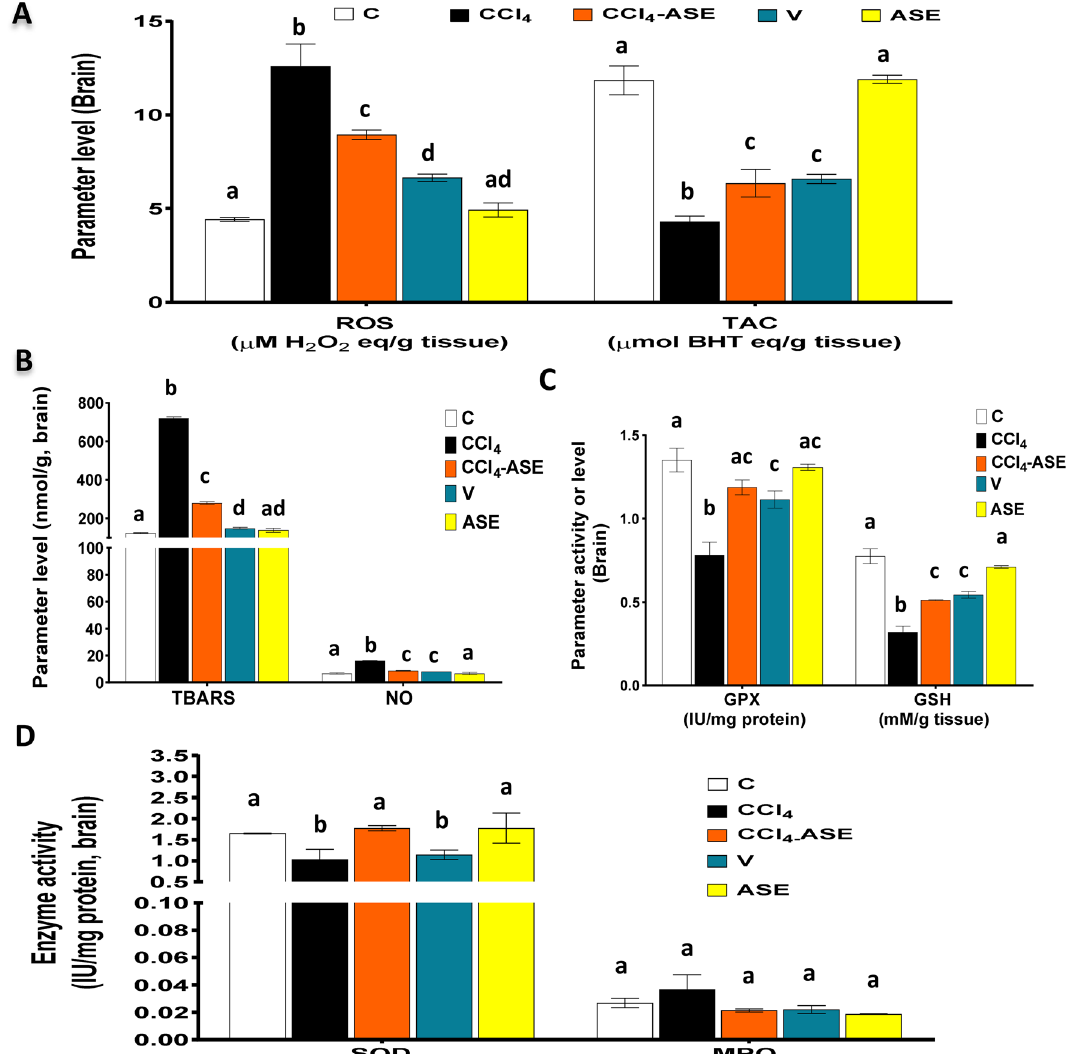
Figure 3. Ameliorating effect of ASE on the CCl 4 -induced redox state disturbance in the brain tissue. ( A ) reactive oxygen species (ROS) and total antioxidant capacity (TAC) levels. ( B ) thiobarbituric acid reactive substances (TBARS) and nitric oxide (NO) levels. ( C ) reduced glutathione (GSH) level and glutathione peroxidase (GPX) activity. ( D ) superoxide dismutase (SOD) and myeloperoxidase (MPO) activities. Results are expressed as mean ± S.E of 7 animals. BHT butylated hydroxytoluene, C control untreated rats, V olive oil (vehicle of CCl 4 )-administered rats (0.5 ml/kg b.w., ip, 6 times), CCl 4 rats with systemic toxicity induced by CCl 4 injection (1 mL/kg b.w., ip, 6 times), CCl 4 -ASE rats with systemic toxicity after their oral treatment with ASE (7.5 g/kg b.w.) for 10 days. ASE , normal rats were administered only ASE (7.5 g/kg b.w.) for 10 days. Different letters refer to the significance at P < 0.05, CCl 4 -ASE group was compared with the CCl 4 group, while V and ASE groups were individually compared with the C